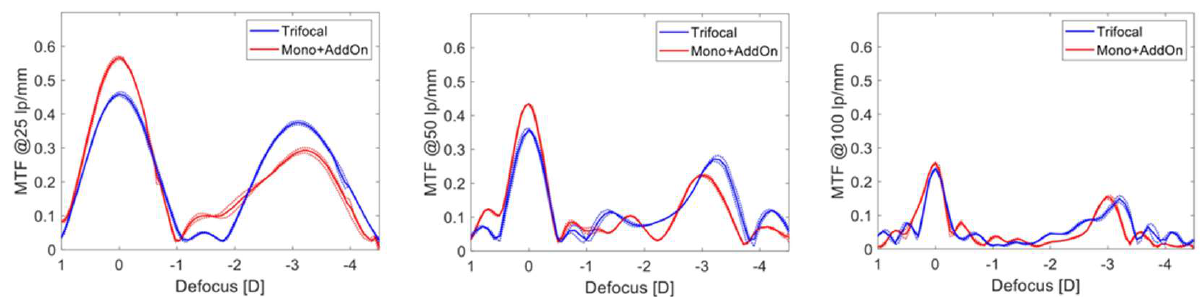
Figure 5. The through-focus modulation transfer function (MTF) of the single-lens trifocal and Mono + AddOn IOLs at 25, 50 and 100 lp/mm for the 3 mm aperture.